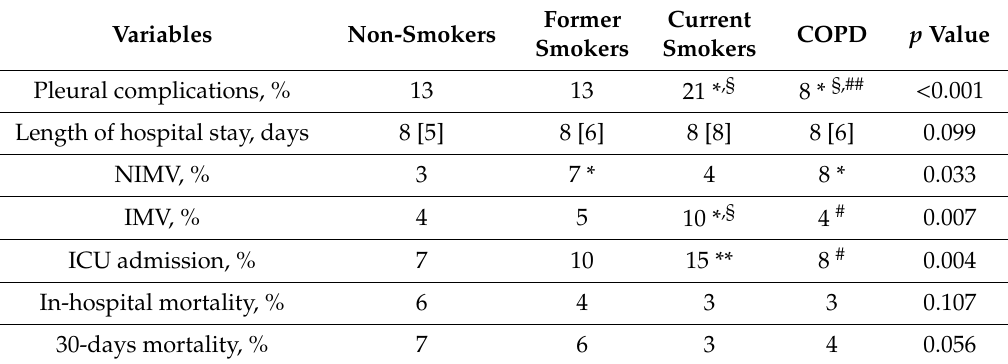
Table 5. Comparison of study outcomes by smoking habit and COPD